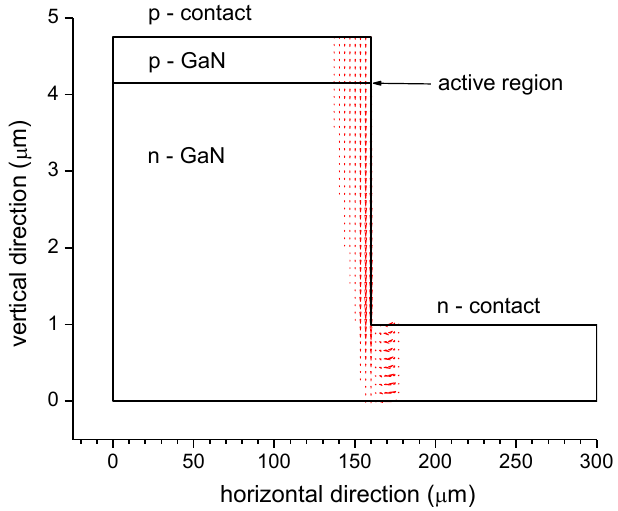
Figure 4. Current distribution (red arrows) calculated in a two-dimensional LED simulation (the arrow size scales with the local current density so that arrows are only visible in high-current regions)